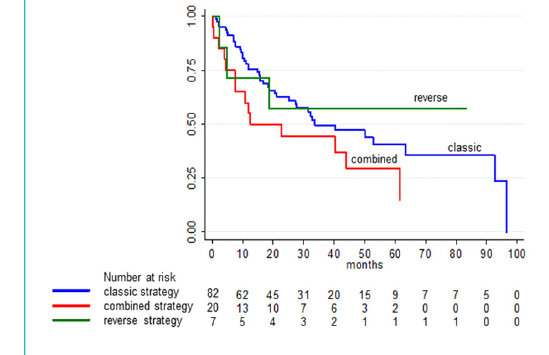
Figure 1: Overall survival according to treatment strategy . The classic approach refers to resection of the primary tumour first fol- lowed by liver surgery. The combined approach refers to simulta- neous resection of the primary tumour and liver metastases. The reverse approach refers to resection of liver metastases before re- section of the primary tumour. In the classic resection group, medi- an overall survival was 40.3 months (IQR 14.9–96.6 months), in the combined resection group 12.5 months (IQR 4.5–61.4 months), and was not reached for the reverse strategy group. Classic vs combined strategy: HR 2.6 (95% CI 1.2–5.7; p = 0.021); classic vs reverse strategy: HR 0.6 (95% CI 0.2–2.1; p = 0.433); combined vs reverse strategy: HR 0.2 (95% CI 0.04–0.98; p = 0.047).